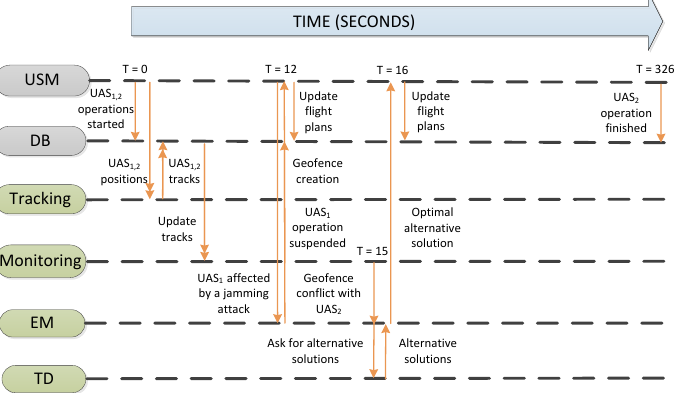
Figure 17. Timeline of the use case 2, where a jamming attack and a geofence conflict are resolved. Single arrows indicate isolated interactions between modules, whereas double arrows indicate periodic